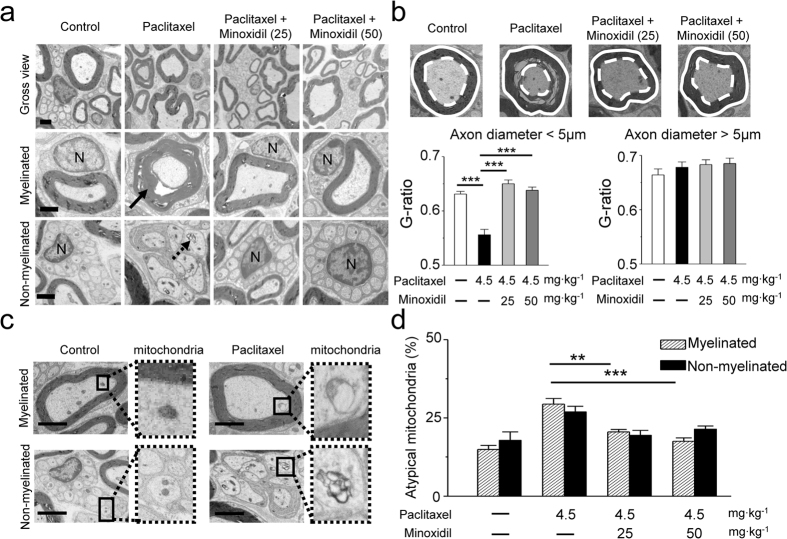
Ultrastructure of mouse sciatic nerve.(a) Transmission electron microscopy (TEM) images. Paclitaxel-induced sciatic nerve damage includes dying axons (black arrow), and swollen intra-axonal mitochondria (black dashed arrow). N, nucleus of Schwann cell. Scale bar, 1 μm. (b) G-ratio measurement in the sciatic nerves: the ratio of axon diameter (white dashed line) to myelin (white solid line). The G-ratio of small fibers (axon diameter <5 μm) and large fibers (axon diameter >5 μm) in mouse sciatic nerves from the four groups are presented. ***P < 0.001 versus paclitaxel treatment, by two-way ANOVA. (c) Representative TEM images show that paclitaxel caused swollen and vacuolated mitochondria (atypical mitochondria). Scale bar, 1 μm. (d) Quantitative analyses of atypical mitochondria indicate that minoxidil can prevent the mitochondrial damage caused by paclitaxel. Each value represents mean ± SEM of at least 100 mitochondria. **P < 0.01; ***P < 0.001 versus paclitaxel treatment, by two-way ANOVA.